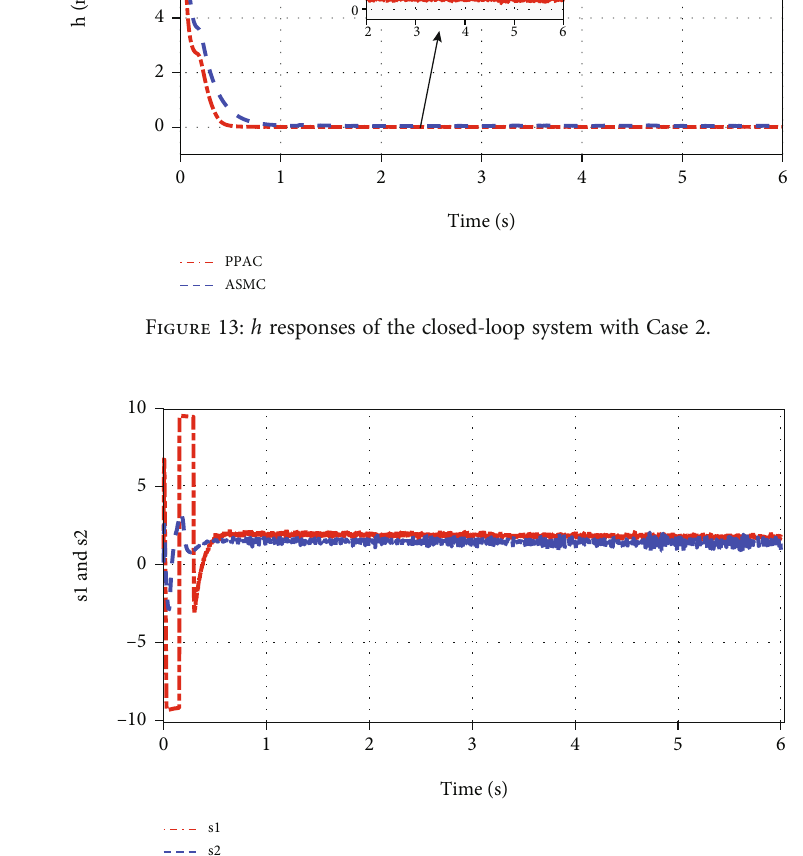
and s responses with Case 1 2